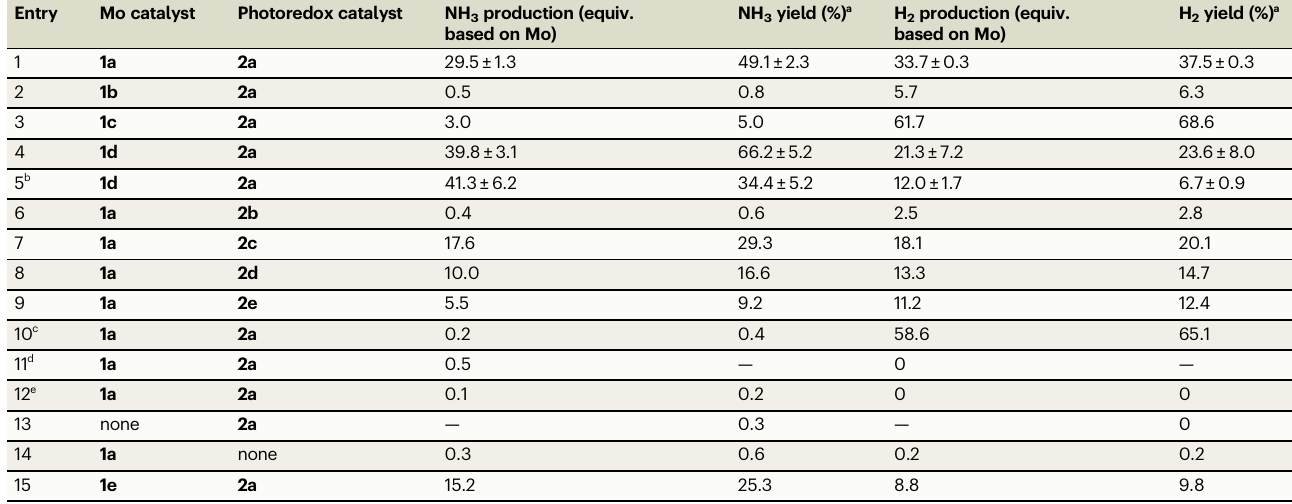
Table 1 | Visible light driven catalytic nitrogen fi xation using molybdenum catalysts and photoredox catalysts Entry Mo catalyst Photoredox catalyst NH 3 production (equiv. based on Mo)